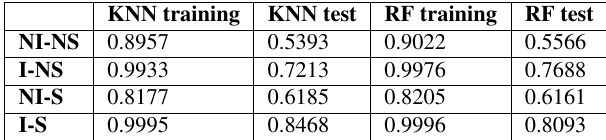
Table 2. Results of 3-fold cross validation for K